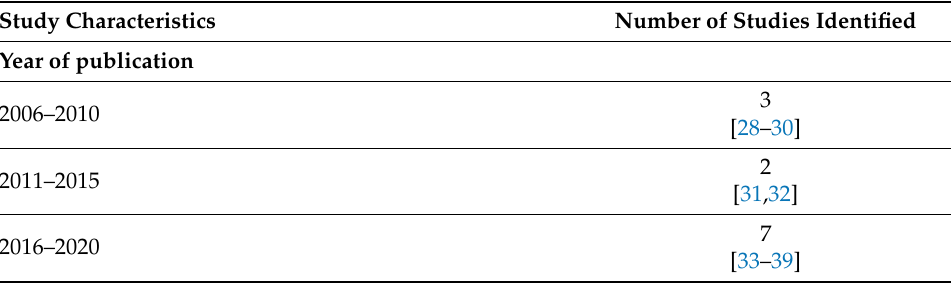
Table 1. Aggregate descriptive summary of economic cost